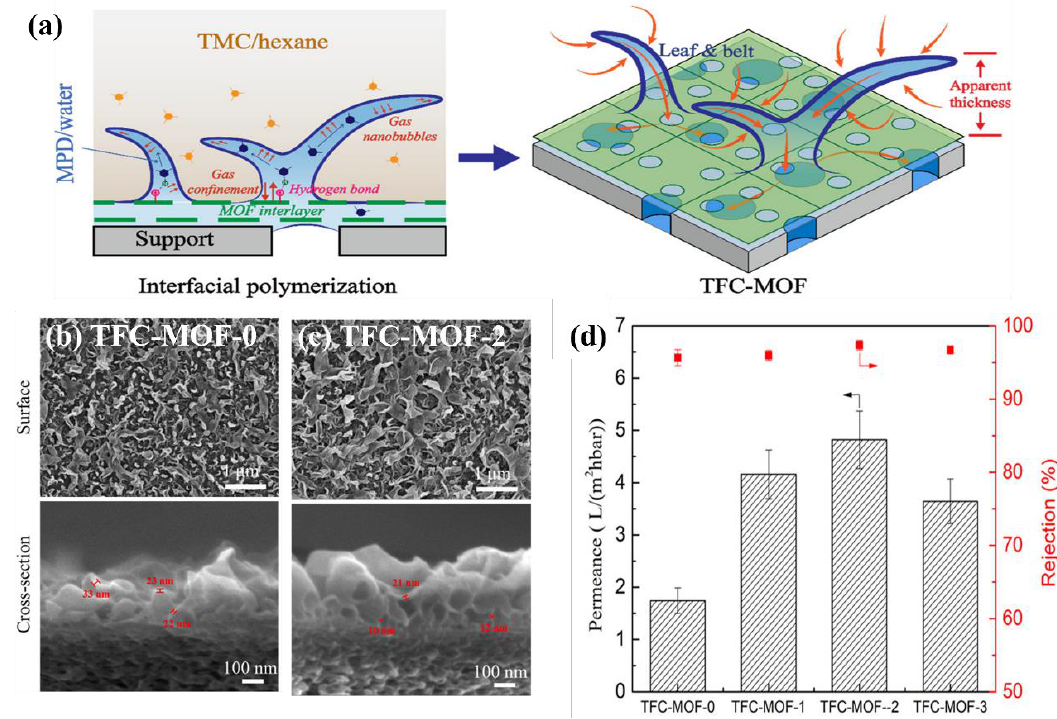
Figure 5. ( a ) Schematic illustration of the effects of incorporating MOF nanosheets on IP process and PA structure; surface and cross-section SEM images of ( b ) TFC-MOF-0 membrane, ( c ) TFC-MOF-2 membrane; ( d ) separation performance of TFC-MOF-0, TFC-MOF-1, TFC-MOF-2, and TFC-MOF-3 membranes, reproduced with permission from Wen et al. [69], with copyright permission from © 2020 American Chemical Society.